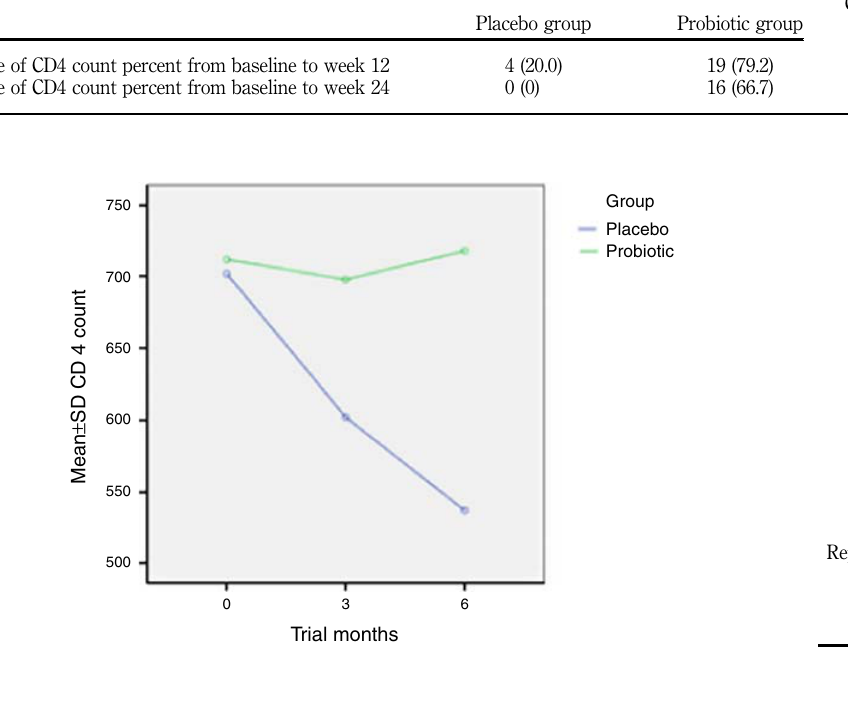
Table III. Comparison of CD4